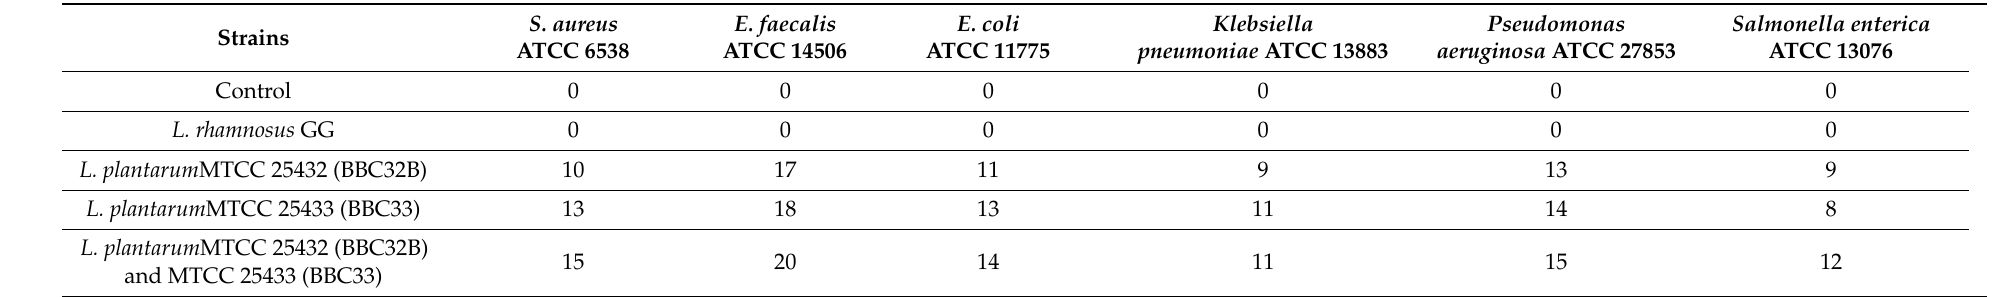
Table 4. Size of zone of inhibition